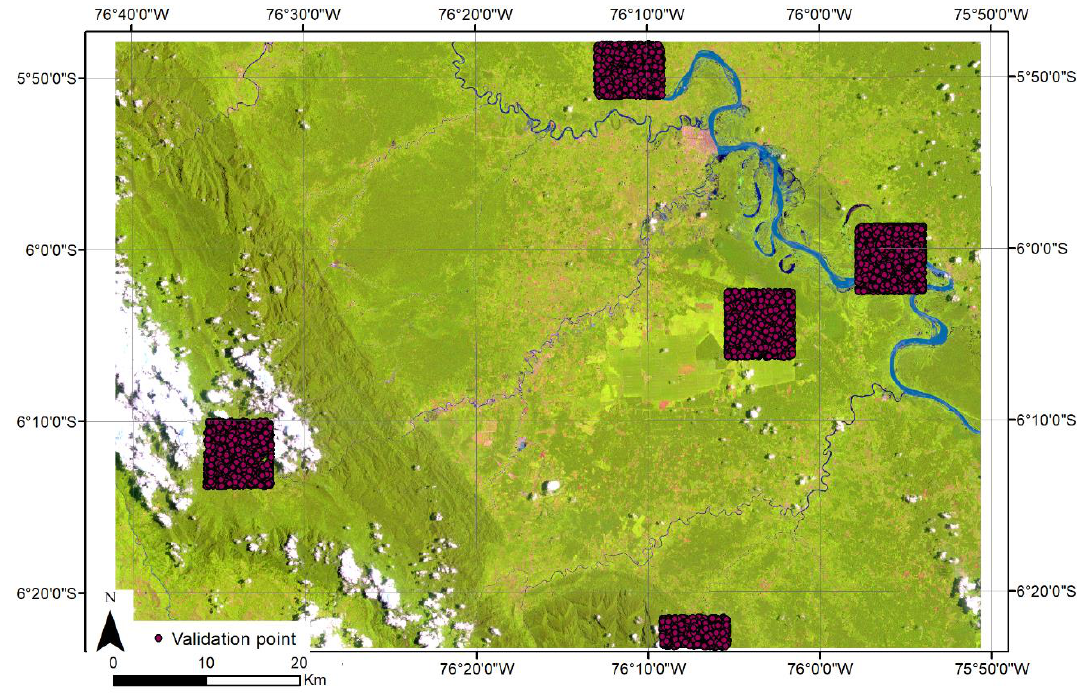
Figure 5. Forest/non-forest (FNF) evaluation in Peru: example of the systematic random sampling